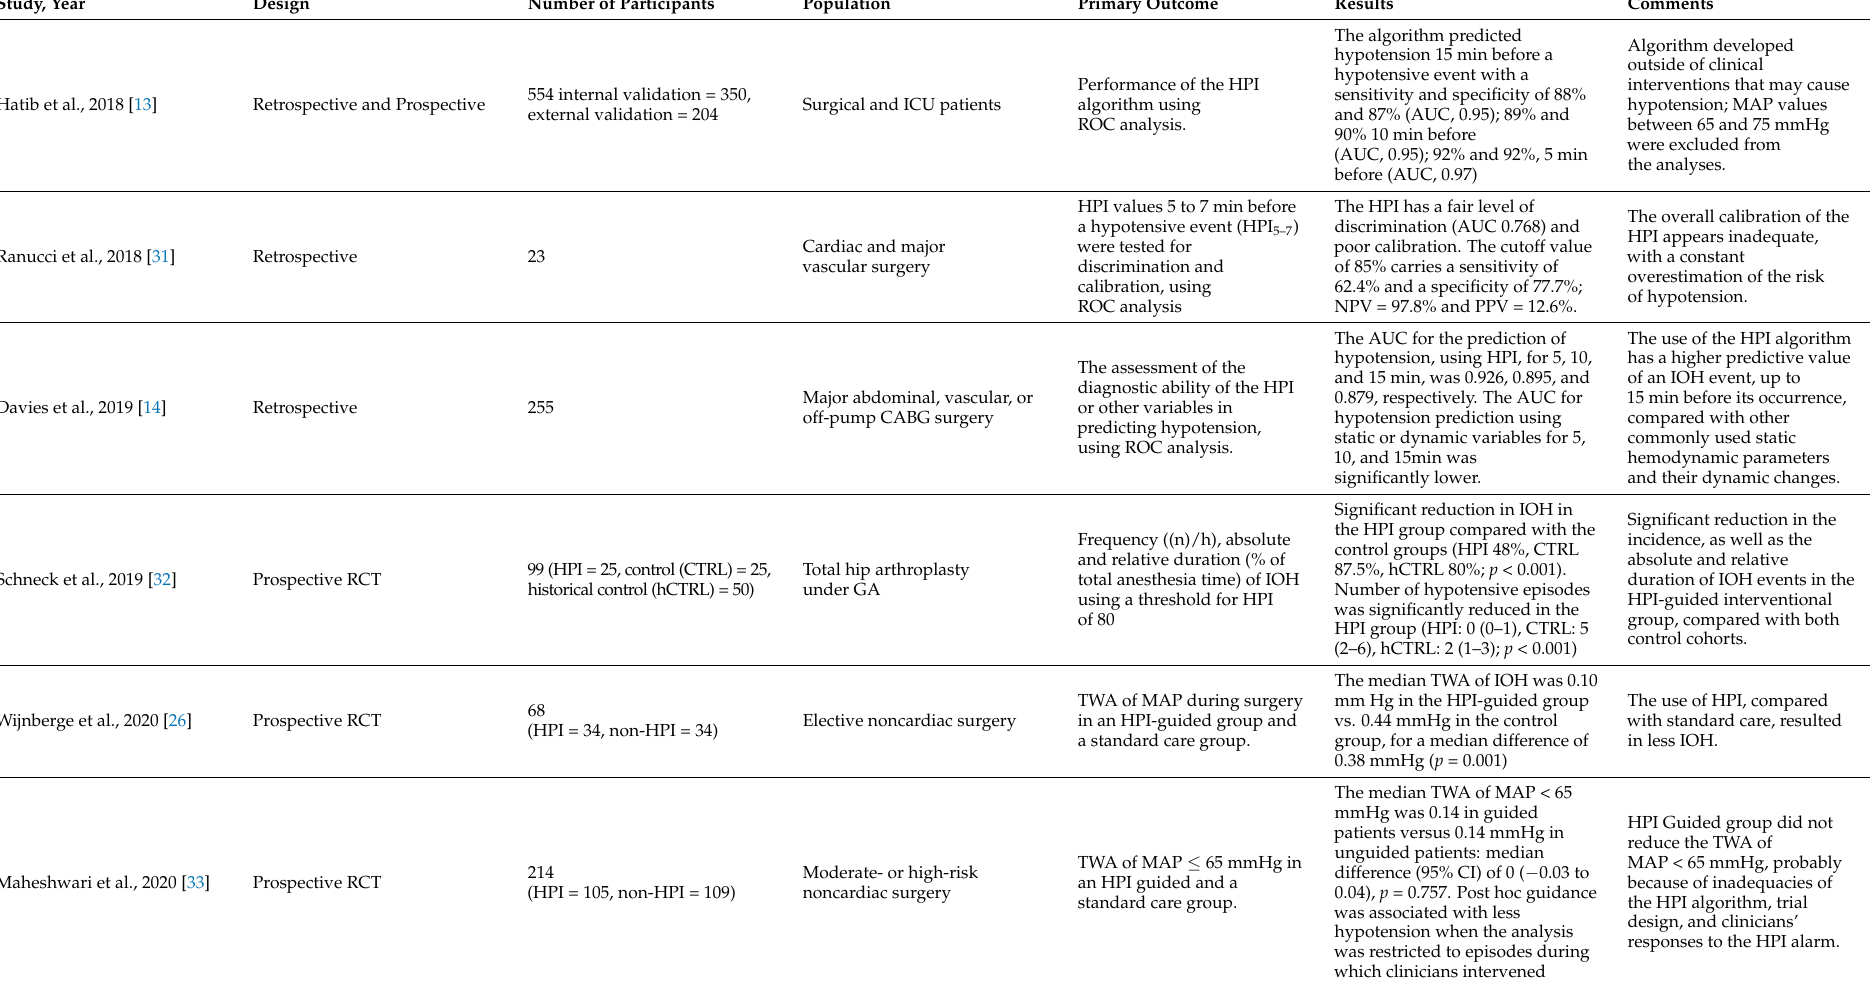
Table 1. Trials validating the HPI algorithm using invasive arterial waveform